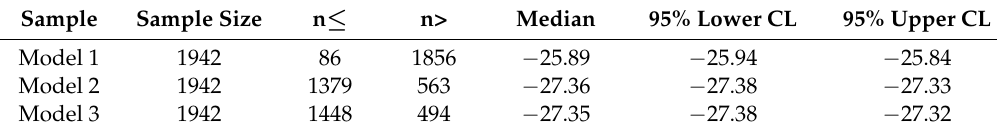
Table 5. Mood’s median test, total n = 5826, grand median = −